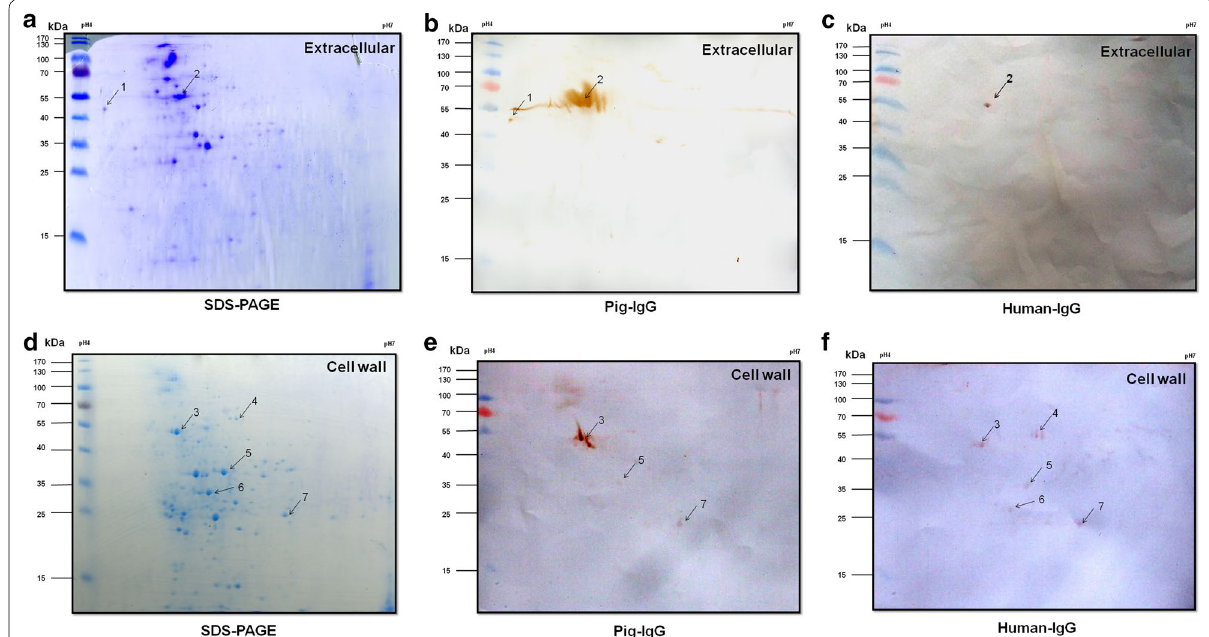
Fig. 1 2-DE profiles and Far-western blot to identify the affinity of pIgG and hIgG interactions with S. suis 2 cell wall and extracellular proteins. The cell wall and extracellular proteins of S. suis 2 were loaded into immobilized pH gradient strips for IEF analysis and by SDS-PAGE in the second dimension. The 2-DE gels were transferred onto PVDF membranes and incubated with pIgG or hIgG. Arrows indicate pIBPs or hIBPs detected with HRP conjugated SPA. a 2-DE gel of S. suis 2 extracellular proteins. b Far-western blot of extracellular proteins incubated with pIgG. c Far-western blot of extracellular proteins incubated with hIgG. d 2-DE gel of S. suis 2 cell wall proteins. e Far-western blot of cell wall proteins incubated with pIgG. f Far-western blot of cell wall proteins incubated with hIgG